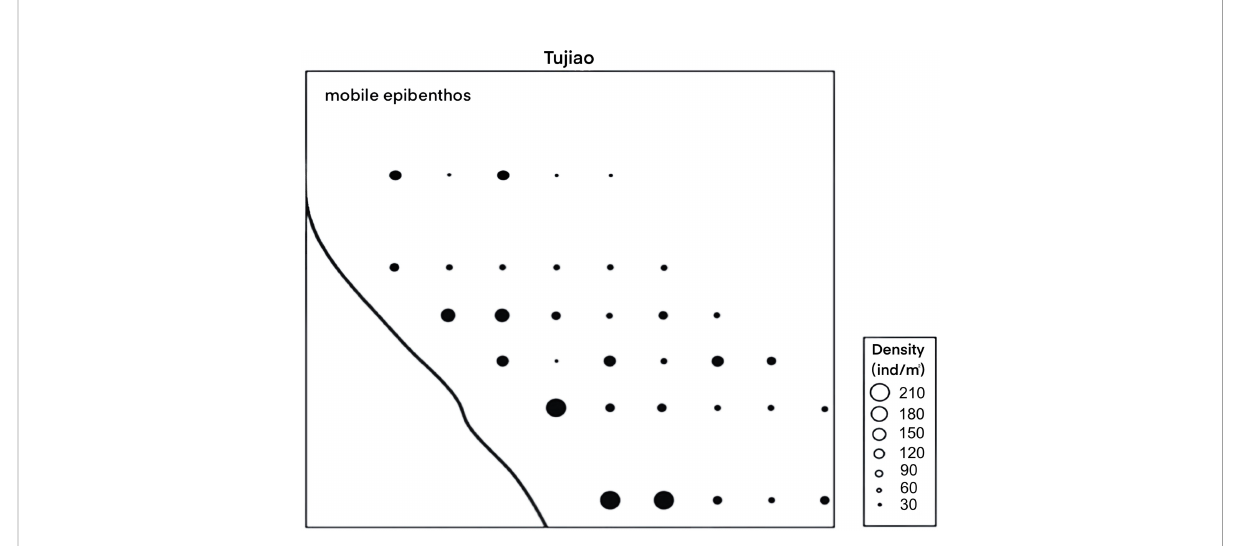
FIGURE 4 Density distribution of mobile